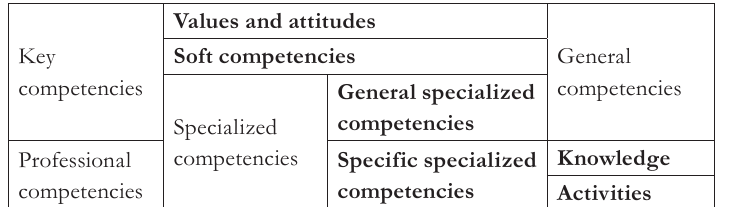
Tab. 1 - Competency model. Source: Ministry of Education, Youth and Sports (MŠMT, 2014),